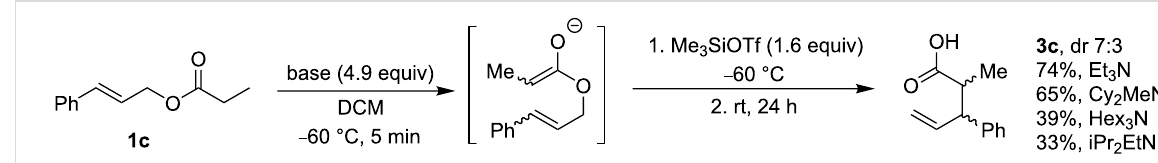
acetal 2b generated from 1b , proceeded with similar yields and diastereoselectivity (Table 1, entries 3–6). However, the Ireland–Claisen rearrangement attempted with cinnamyl pro- pionate ( 1c ) did not take place when using LDA as a base (Table 1, entries 7 and 8). Next, we studied the Ireland–Claisen rearrangement of ester 1c using various tertiary amines as bases. The ester enolate was trapped with Me 3 SiOTf at − 60 °C and allowing the reaction to were achieved with triethylamine (74%) and N -cyclohexyl- N - methylcyclohexanamine (65%, Scheme 2) whereas reactions with trihexylamine and diisopropylethylamine provided